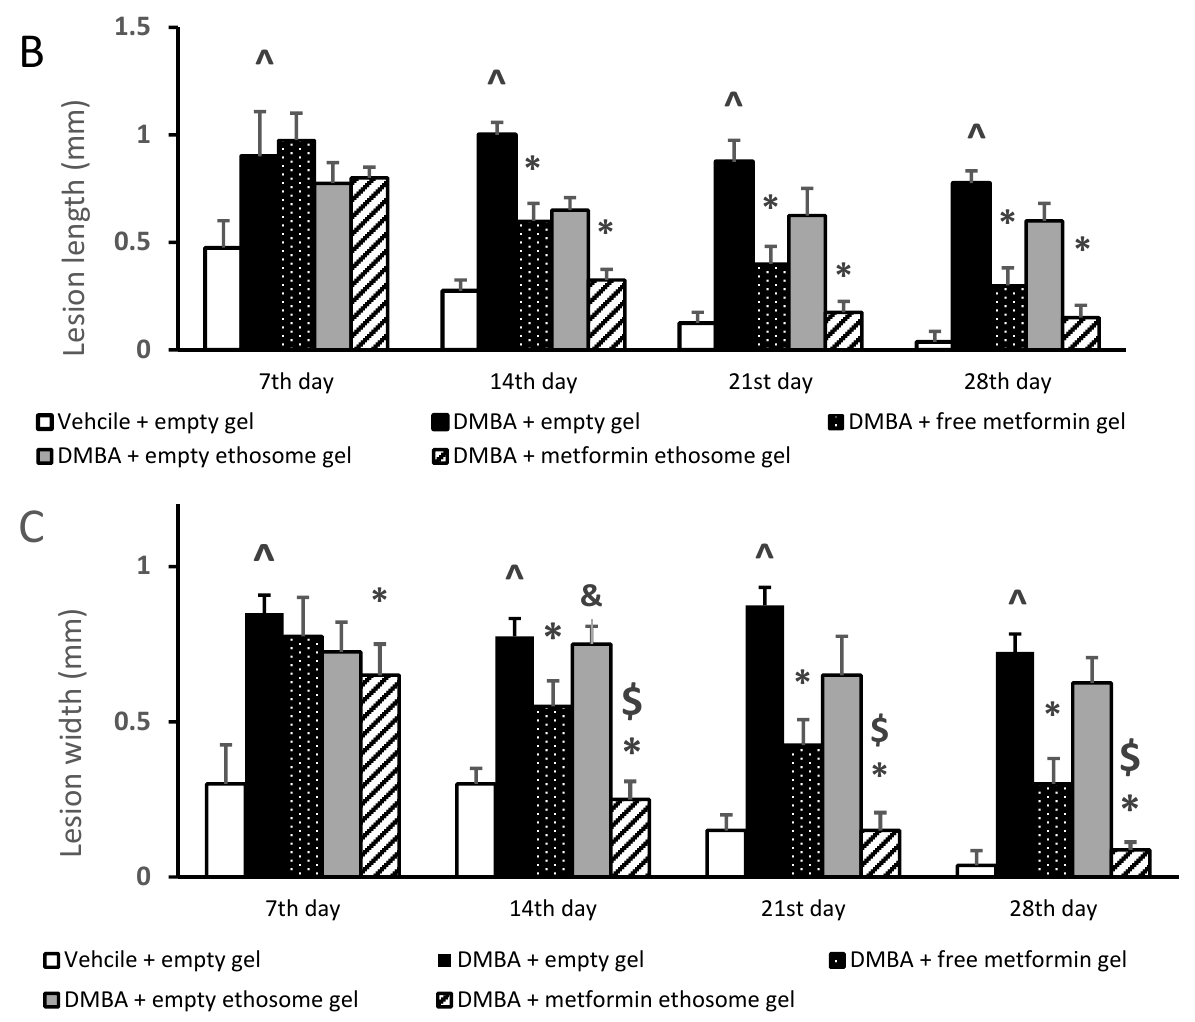
Figure 8. Body weights and dimensions of the skin lesions in the experimental groups. ( A ) Mice body weights, ( B ) lesion lengths (mm) and ( C ) lesion widths (mm). Data were the mean ± SD and analyzed using one-way ANOVA, followed by Bonferroni’s pairwise comparison test ( p < 0.05). ˆ: versus the vehicle + empty gel group, *: versus the DMBA + empty gel group, &: versus DMBA + free metformin gel. $: versus DMBA + empty ethosome gel.